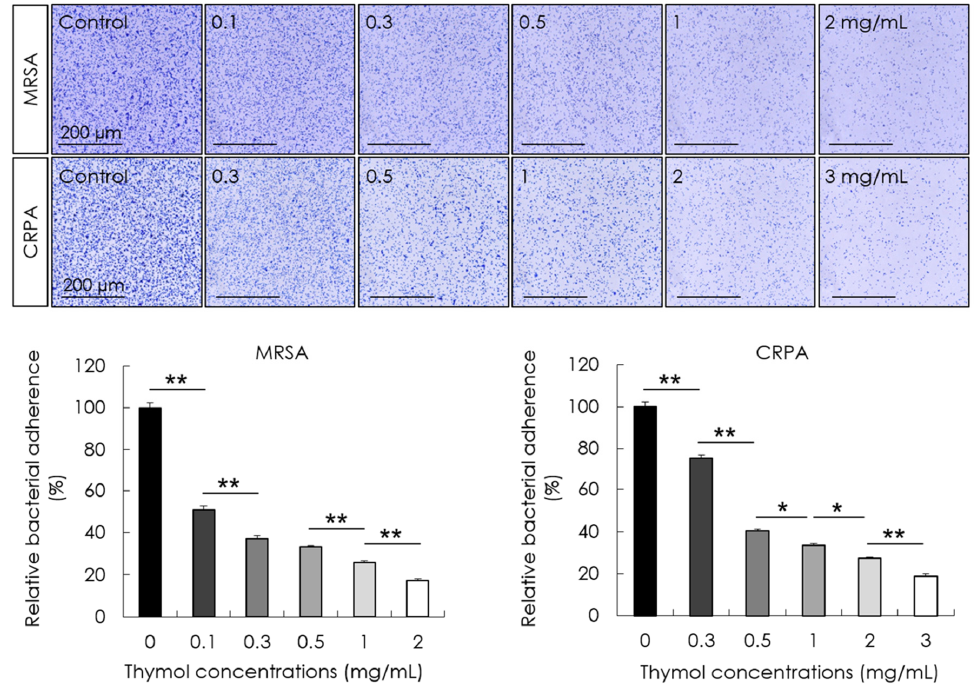
Figure 2. The effects of thymol on the adhesion of methicillin-resistant Staphylococcus aureus (MRSA) and ciprofloxacin-resistant Pseudomonas aeruginosa (CRPA). The adherent MRSA and CRPA strains were stained using crystal violet following a 30 min treatment with thymol (top). Thymol significantly reduced the adhesion of MRSA and CRPA in a concentration-dependent manner. Data are shown as the means ± standard errors of the mean of five independent experiments (** p < 0.01; * p < 0.05).